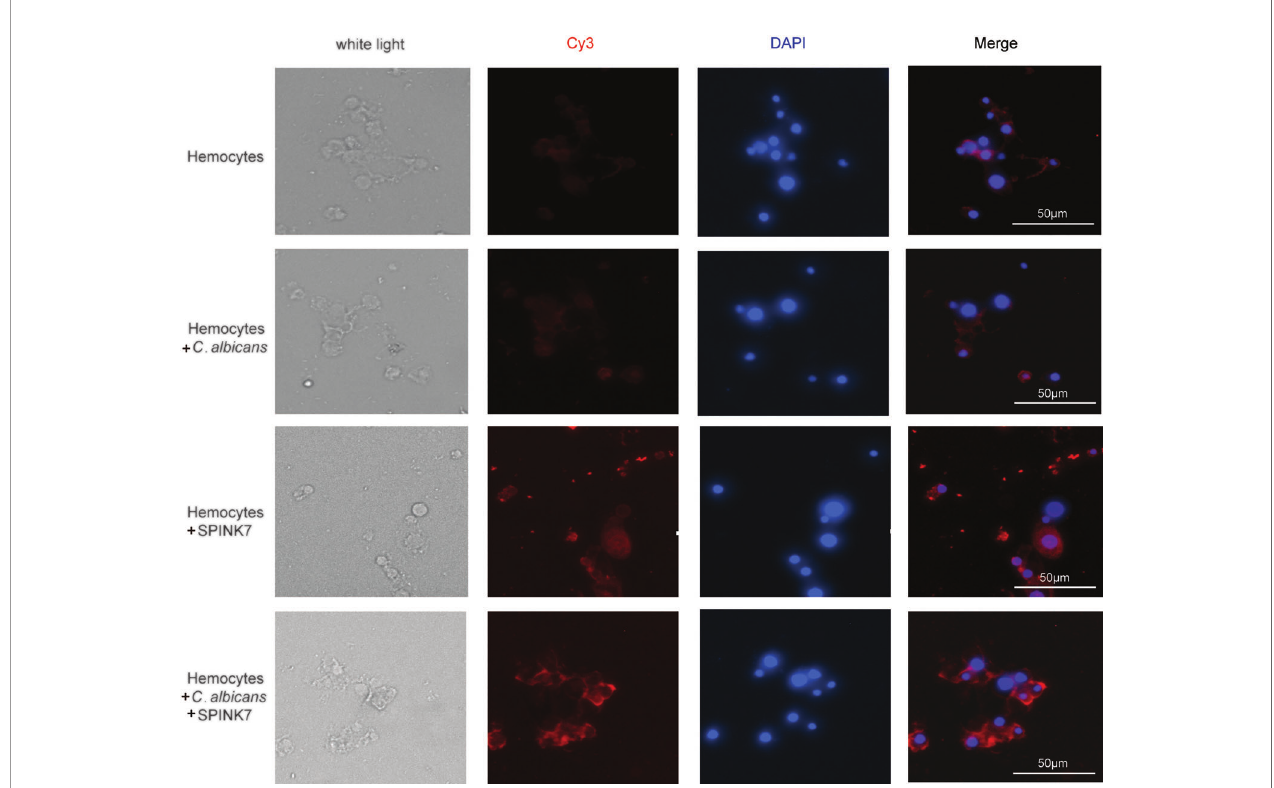
FIGURE 10 | Immuno fl uorescence visualization of SPINK7 in B. mori hemocyte immunity. Overlay experiments were performed on hemocyte monolayers prepared by seeding 5×10 3 hemocytes collected in phenylthiourea onto poly-L-lysine-treated glass slides. About 10 m L SPINK7 (5 m g m L -1 ) and 10 m L heat-killed C. albicans (1×10 5 conidia mL -1 ) were added to hemocyte monolayers and incubated at 25°C for 2 h. Slides were incubated with anti-SPINK7, followed by Cy3-labeled goat anti-rabbit (red)